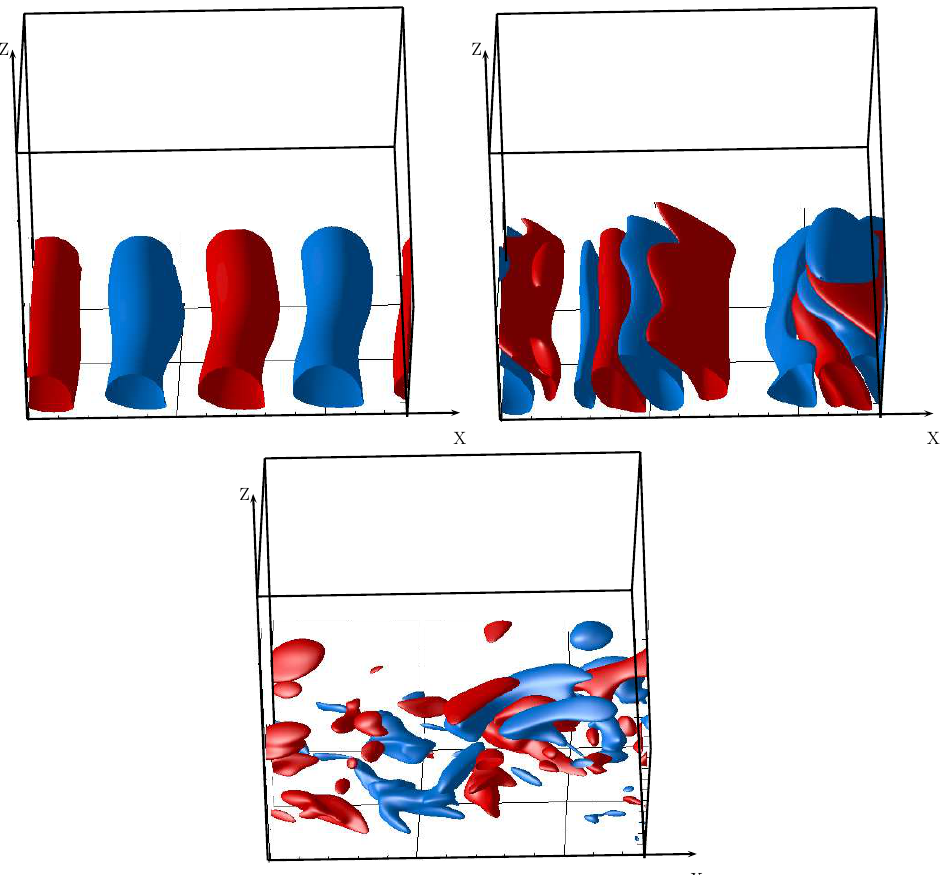
Fig. 7. Isosurfaces of velocity component w at t i = 12h (left; w = ± 10 − 4 ms − 1 ) 18h (middle; w = ± 10 − 3 ms − 1 ) 20h (right; w = ± 10 − 3 ms − 1 ). Red color is upward and blue color downward. The Ekman rolls (left) become unstable (middle) leading to turbulence (right). The domaine spans 256m in the x and y-direction and 223.5m in the z-direction.